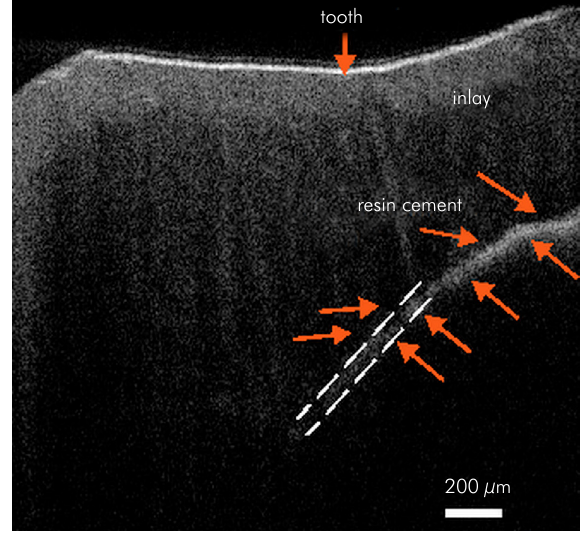
Figure 4. A representative of optical coherence tomographic scan with transversal view of a tooth after inlay cementation. The marginal adaptation was measured from cement thickness.